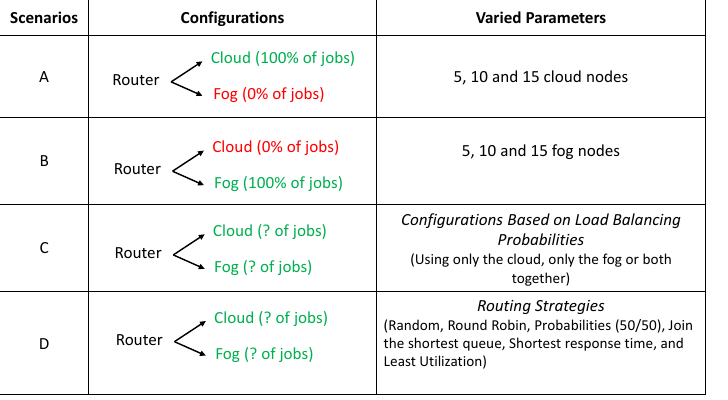
Figure 3. Overview of the four evaluated scenarios. Color green indicates that the request will be transmitted to that target whereas color red means the